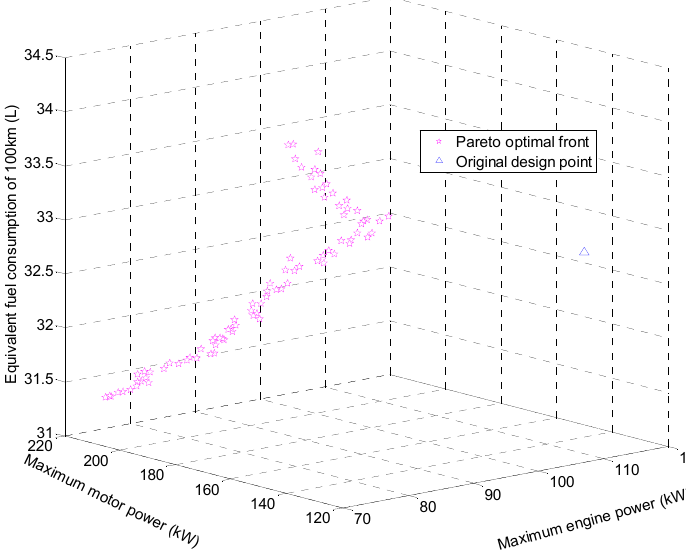
Figure 13. 3D point of multi-objective optimization results.